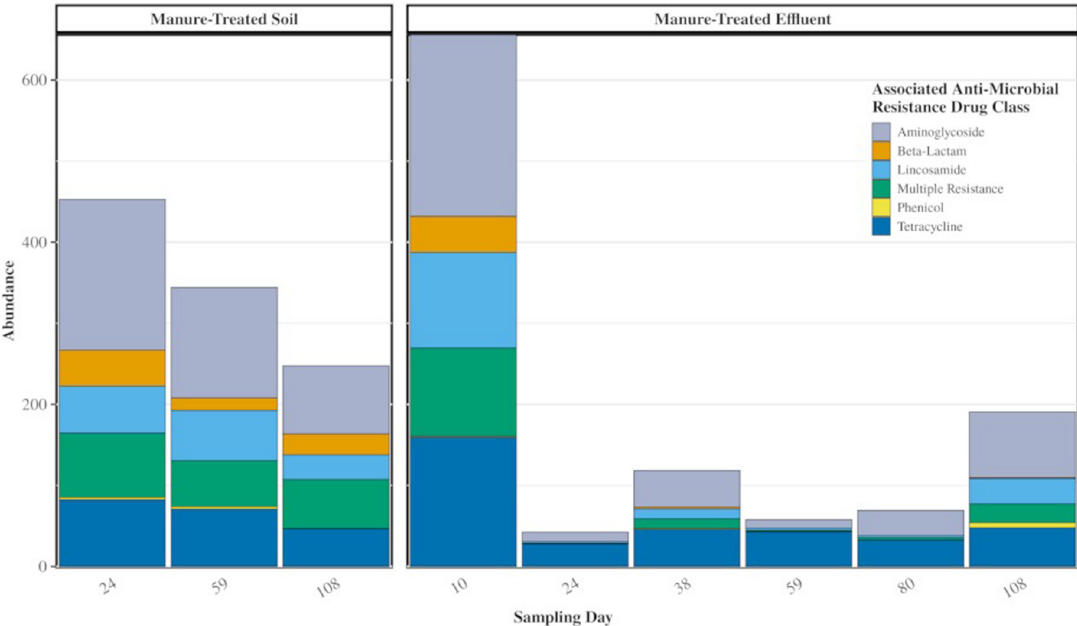
Fig 4. Abundance of persister ARGs observed in manure-treated soil and manure-treated effluent samples after each rain event. Abundance is averaged for 4 replicate samples at each time point and normalized by number of recA genes present in each sample. “Multiple Resistance” for ARG classification refers to any gene that has been annotated as associated with more than a single antibiotic